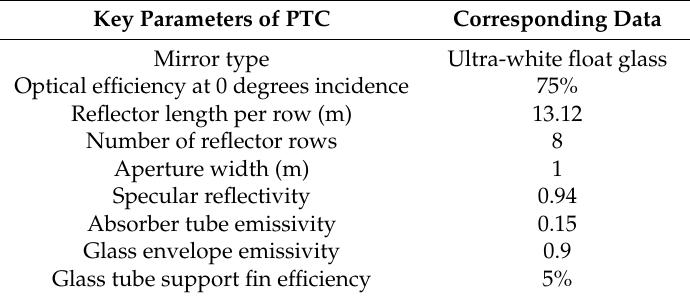
Table 1. Key design factors of